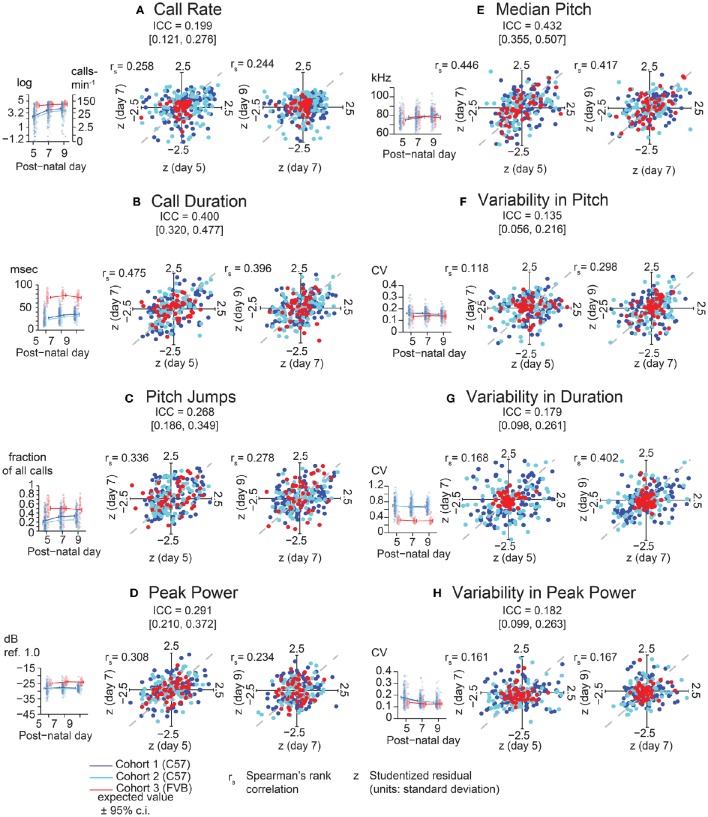
Lack of Strong consistency across pup USV features in Pooled Cohort Study (PCS). Each panel shows: (left) the value of the ICC with its boostrapped 95% confidence interval, the data, with bee plots of individual animals, and trend lines, color-coded by cohort [blue, Cohort 1 (C57BL/6J, N = 133); cyan, Cohort 2 (C57BL/6J, N = 105); red, Cohort 3 (FVB/AntJ N = 47)]; showing expected values from the LMM [fixed effects only, w = 0 (average weight)] ± bootstrapped 95% confidence intervals on regression estimates (right) Studentized residuals (z) after adjusting for fixed effects plotting day 5 vs. day 7, and day 7 vs. day 9, and their respective Spearman rank correlation coefficients. The ICC is a summary statistic for each USV feature's consistency, but note that Spearman rank correlation coefficients are typically within or near the range of the respective ICC's confidence bounds. (A) Call Rate (calls-min−1). LMM was fitted on log(counts+1minutes) (abbreviated “log” on y-axis) with data (left panel) shown alongside linear scale values for ease of interpretation. LMMs can tolerate missing data points, and not all animals have data on all three time points due to pup death. Residual plots and associated correlation coefficients were only computed for animals with data on all three time points: N = (1) 119, (2) 101, (3) 47. (B) Call Duration (averaged over all calls, milliseconds). (C) Pitch Jumps (fraction of all calls). (D) Peak Power (averaged over all calls , dB ref. 1.0). (E) Median Pitch (averaged over all calls, kHz). (F) Variability in Pitch. (G) Variability in Duration. (H) Variability in Peak Power (F–H): [coefficient of variation (σ/μ) over all calls]. Other than call rate (A), other features of USV (B–H) were only computed for animals possessing at least 10 calls [Day 5: N = (1) 114, (2) 90, (3) 47 | Day 7: N = (1) 122, (2) 99, (3) 47 | Day 9 N = (1) 116, (2) 98, (3) 46]. LMMs fitted in R using lme4 with models in Wilkinson notation as: feature ~cohort∗w∗(d+d2)_fixed effects+(1|id)_random effect where cohort is categorical, w is a z-score of the animals weight by cohort and day reflecting its relative size, and d is postnatal day centered around day 7, fitting both linear and quadratic terms, and (1|id) is a random intercept for each animal. Residual plots for (B–H) had at least 10 calls and data for all time points, N = (1) 98, (2) 80, (3) 46. Highest ICC was observed for call duration with ICC = 0.400 [0.320, 0.477], with rank correlations of 0.475 on day 7 vs. day 5, and 0.396 on day 9 vs. day 7, and median pitch ICC = 0.432 [0.355, 0.507], with correlations of 0.446 on day 7 vs. day 5 and 0.417 on day 5 vs. day 9. Most features of USV have values off ICC near 0.3 or 0.2 indicating overall low levels of day-to-day consistency. Gray dotted lines show correlation of 1.0 for comparison.